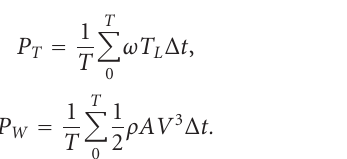
Δ V = 2 m/s, a di ff erence exists between the experimental results and those from the simulation depicted by the